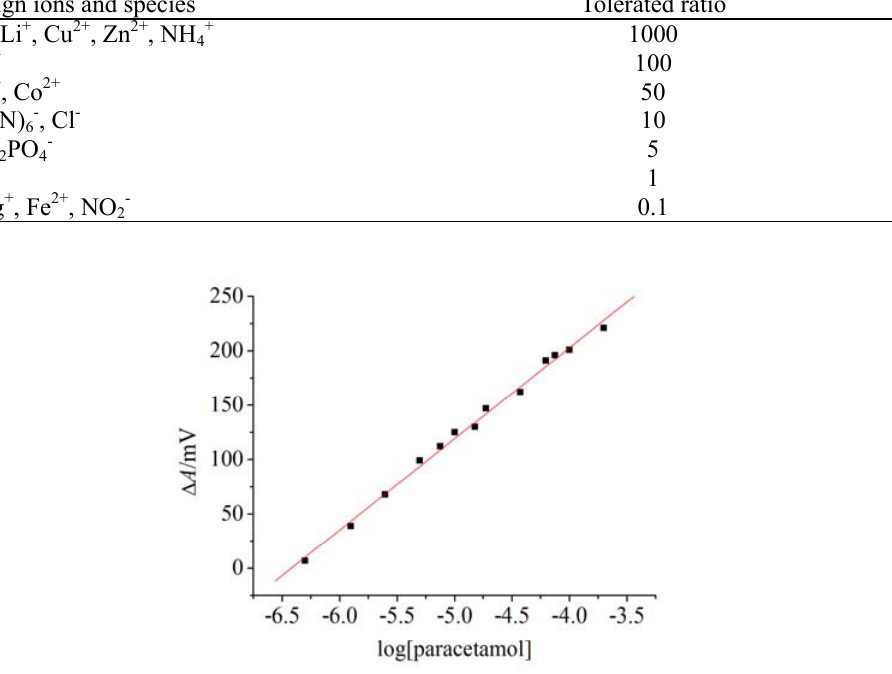
] = 1.875×10 -2 M; [malic acid] = 0.20 M; 3 ) ] = 3.04×10 -3 4 2